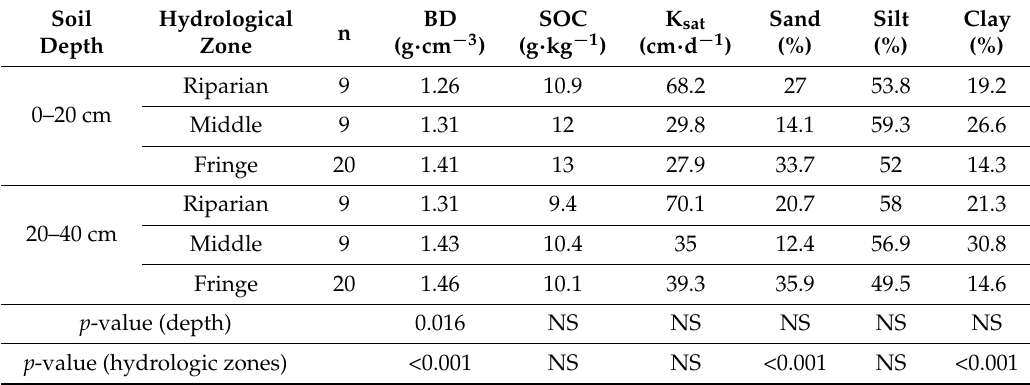
Table 2. Spatial variability of mean values of selected soil properties for the three defined hydrological zones at 0–20 cm and 20–40 cm